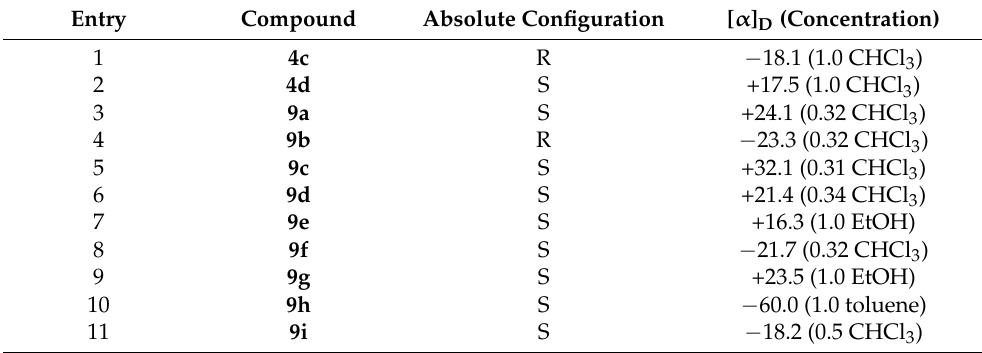
Table 3. Absolute configurations and optical rotations for ITCs 4c – d and 9a – i .